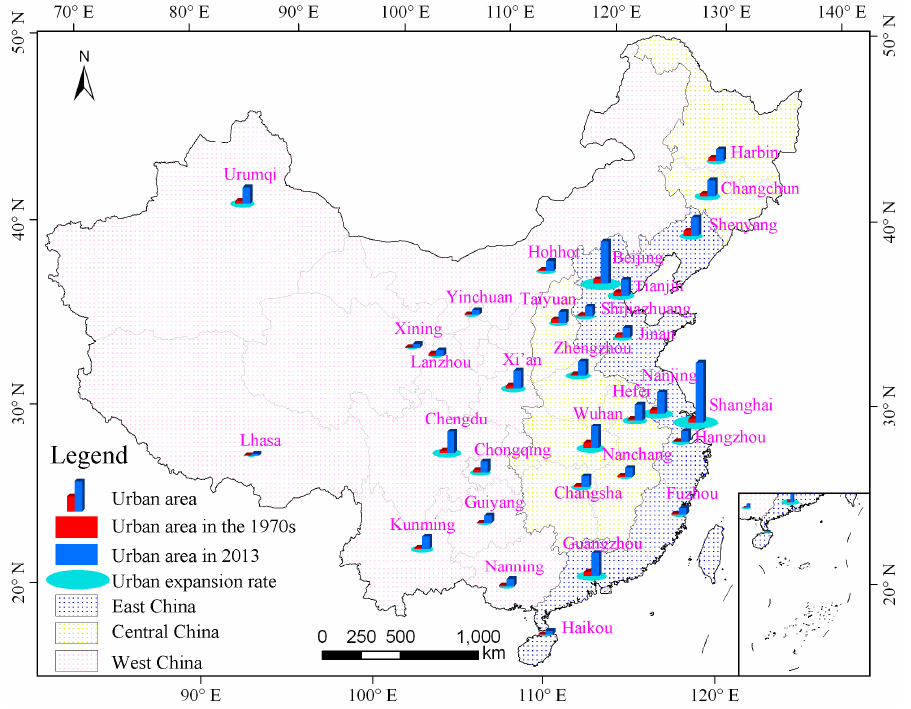
Figure 4. Pace of urban expansion in the 31 sample cities from the 1970s to 2013.